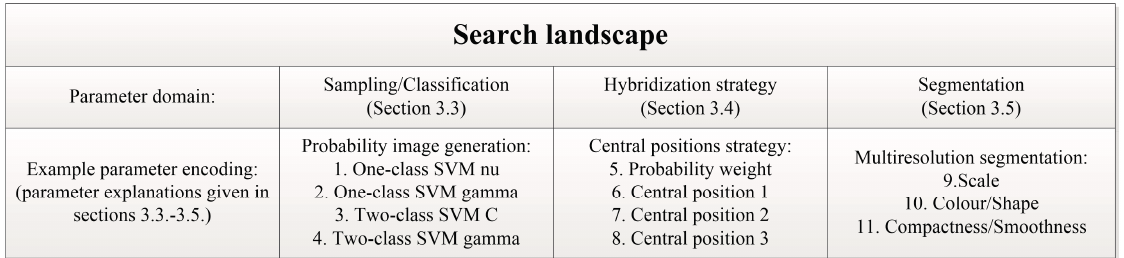
Figure 4. An example parameter set, forming the search landscape with interdependent real-valued parameter domains